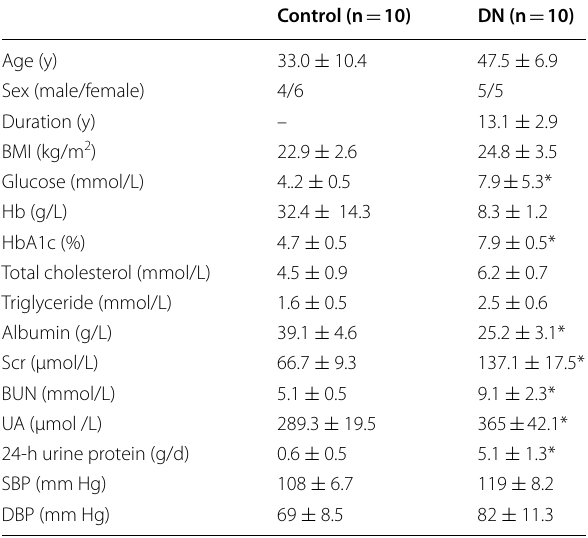
Table 1 Clinical characteristics of the